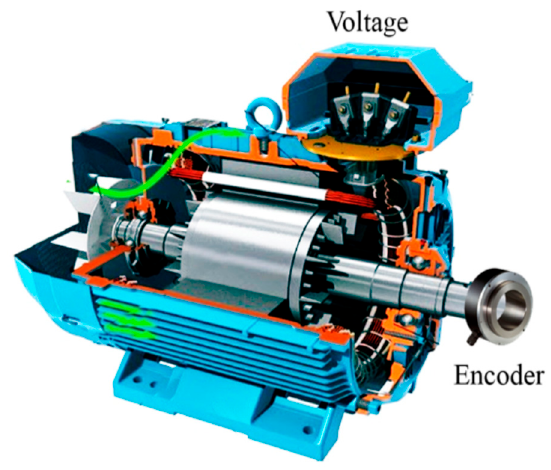
Figure 3. Graphical illustration of the motor components.